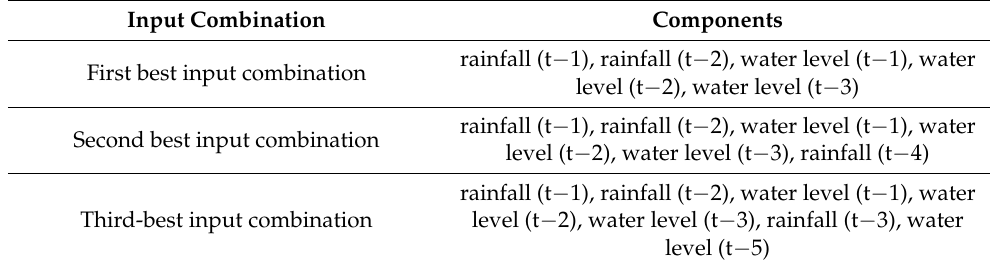
Table 2. The best input combinations.